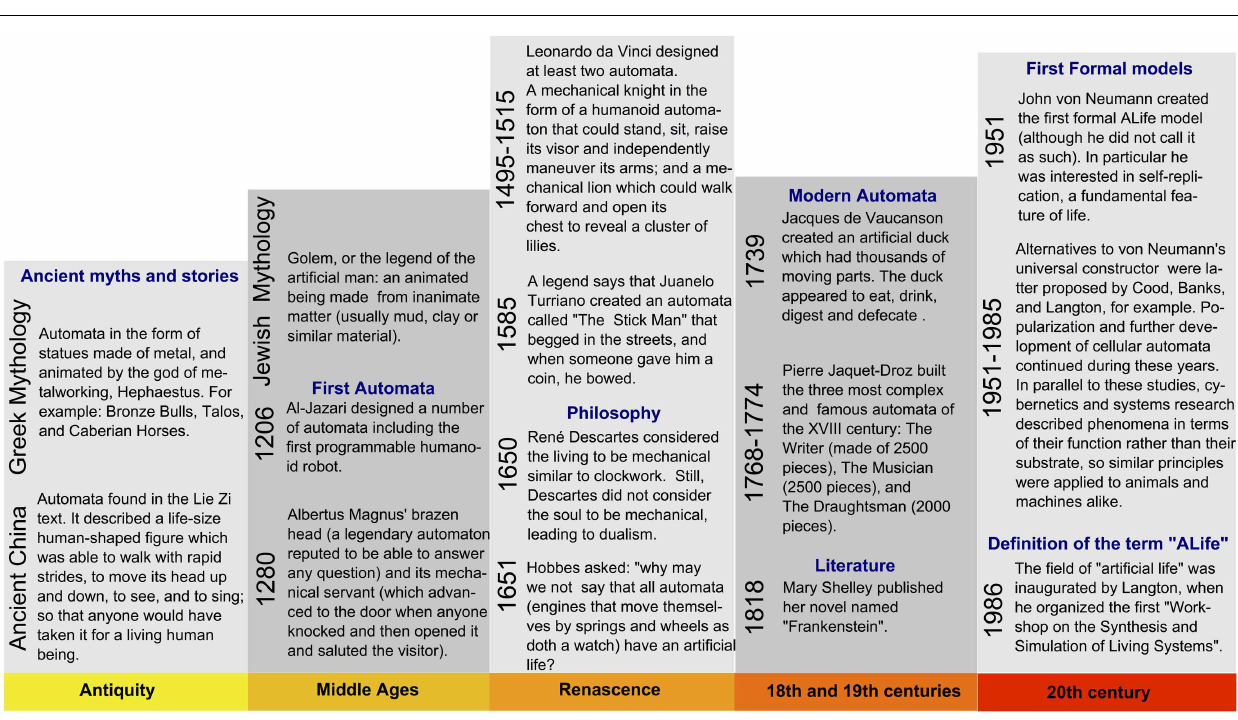
ALife has been an interdisciplinary research field